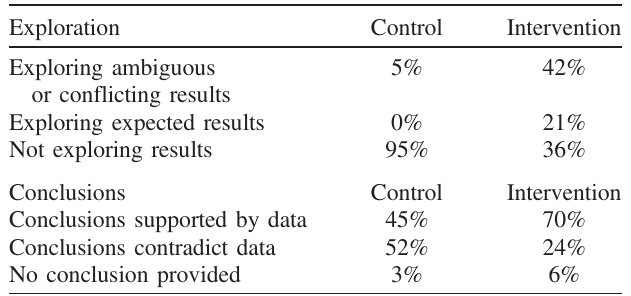
TABLE IV. Percent of student groups engaging in various scientific (and nonscientific) practices across labs D and E. Differences between conditions were statistically